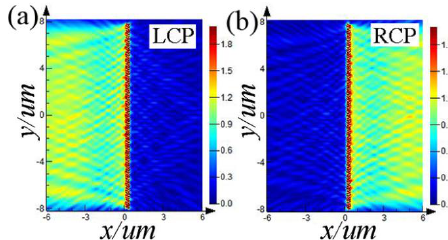
Figure 3. Numerical verifications on the feasibility of polarization controlled tunable directional launching of SPP waves by an I-shaped device shown in Figure 1d under illumination with ( a ) LCP light and ( b ) RCP light.